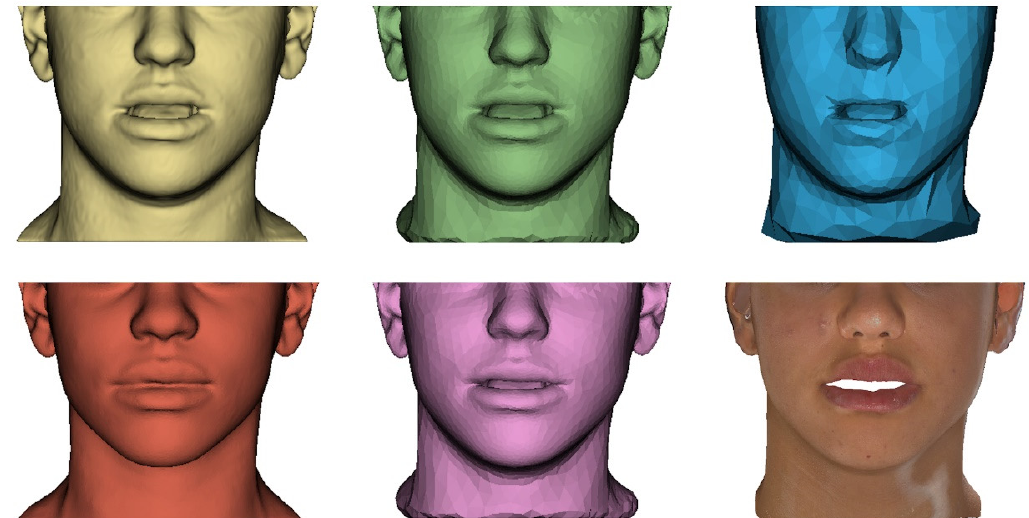
Figure 3. Example of the soft tissue meshes shown in the qualitative validation process for one patient. From left to right: in the first row, segmentation mesh from the preoperative CBCT image, fine mesh and coarse mesh; in the second row, segmentation mesh from the postoperative CBCT image, simulation result for the fine mesh and textured simulation result for the fine mesh.